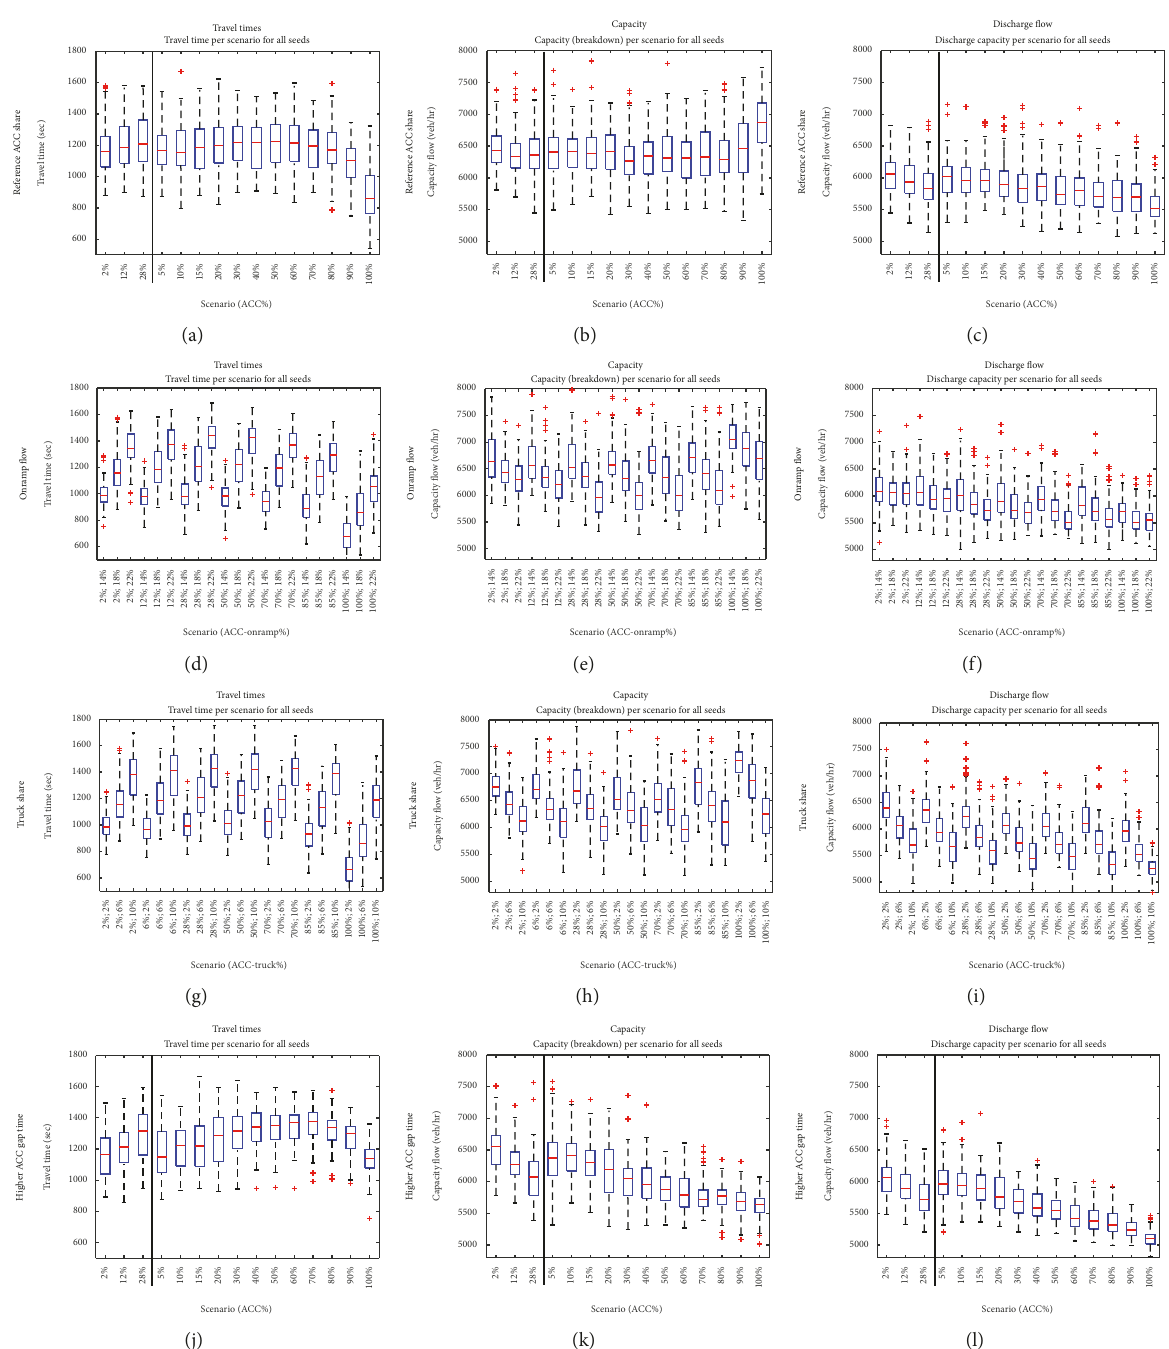
Figure 5: Results of all scenarios for the four scenario groups (vertical) and three performance indicators (horizontal). “+” represents outliers.